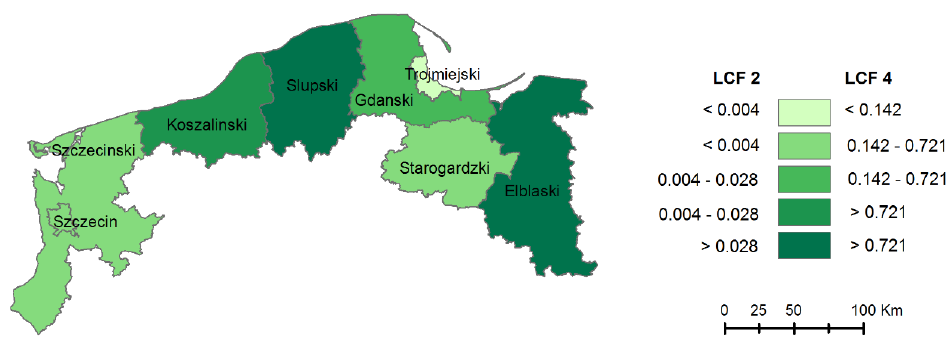
Figure 10 . Choropleth map of LCF2 and LCF4 in percent. Figure 10. Choropleth map of LCF2 and LCF4 in percent.